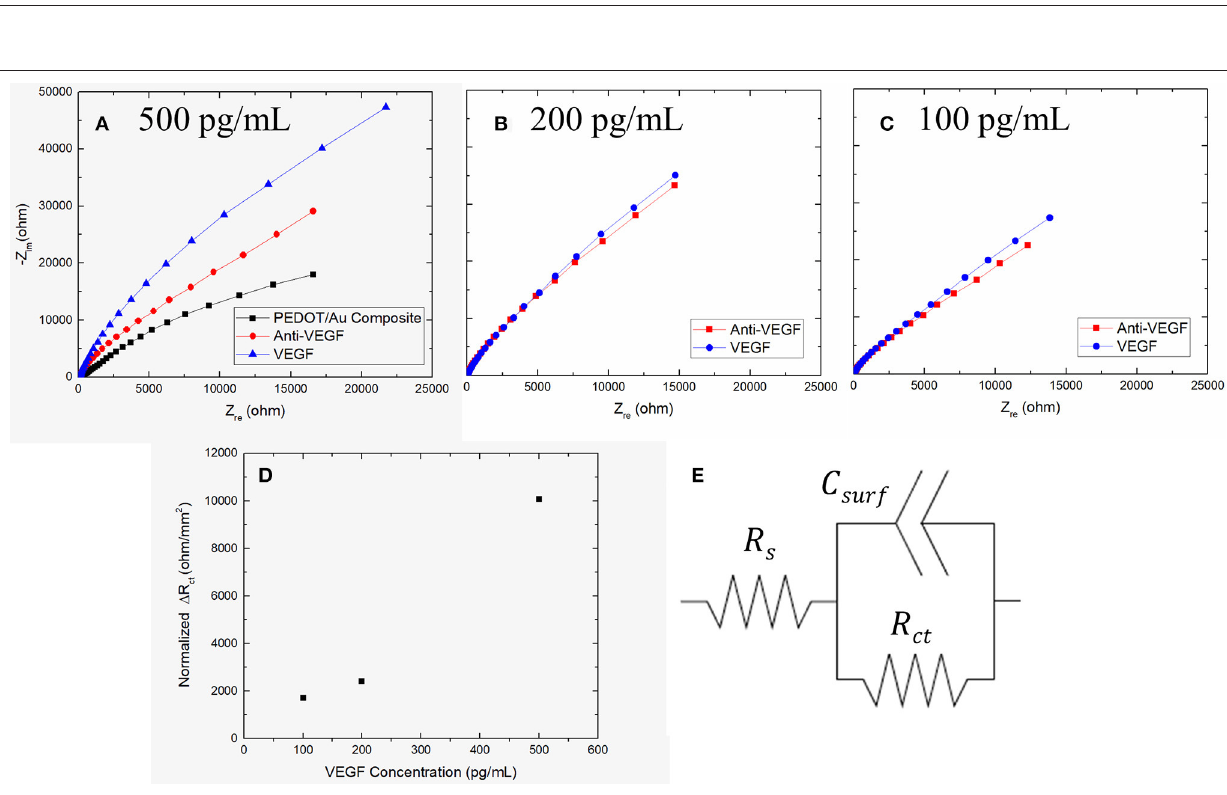
Frontiers in Chemistry |